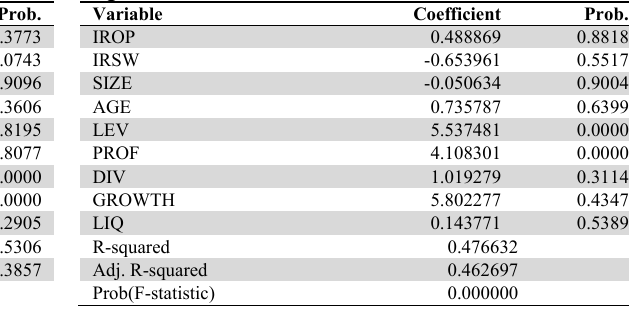
Regression Model 3 Results Regression Model 4 Results